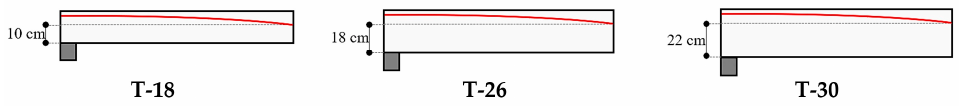
Figure 13. Thickness settings on Series T models.